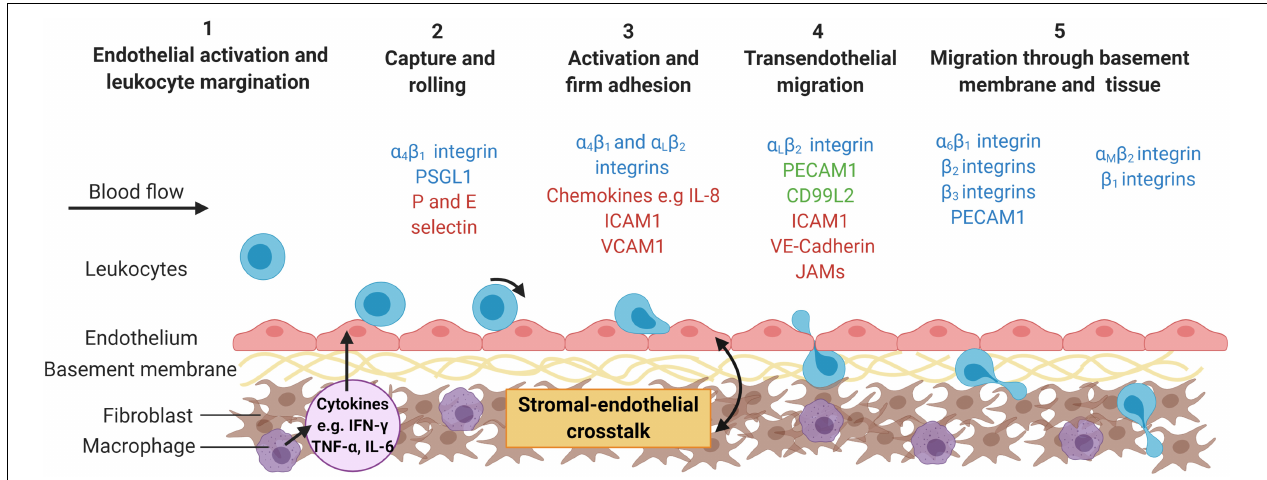
FIGURE 1 | The multi-step leukocyte adhesion cascade. Infection or tissue damage causes the localized release of danger signals, including cytokines, which (1) activate the endothelium causing the expression of capture receptors (P- or E-selectins), adhesion molecules (IgSF members – ICAM-1; VCAM-1) and presentation of chemokines or lipids on their surface (2) (Zhang et al., 2011). Marginated leukocytes are captured, roll along the endothelial surface until (3) they receive an activation signal (typically chemokine mediated) resulting in inside-out signaling and integrin activation ( α L β 2 -integrin; α 4 β 1 -integrin) (Ley et al., 2007). This allows for stabilization of the adhesive interactions ( α L β 2 -ICAM-1 and α 4 β 1 -VCAM-1 interactions) and cytoskeletal rearrangement in the leukocyte allowing (4) them to crawl over the endothelium, migrate across the endothelium (ICAM-1; JAM-1; CD31; VE-cadherin) and into the subendothelial space (Ley et al., 2007), (5) where they encounter the basement membrane and stromal compartment. This process is tightly regulated by the haemodynamic forces of the flowing blood and the stromal derived signals experienced by the endothelium (McGettrick et al., 2012). Some of the major molecules involved in this process are represented in the schematic, with molecules colored according to cell type expressing them; leukocytes = blue; endothelial cells (ECs) = red and expressed by both leukocytes and ECs = green. ICAM-1, Intracellular adhesion protein 1; IL-8, interleukin-8; JAM, junctional adhesion molecule; PECAM-1, platelet endothelial cell adhesion molecule 1; PSGL1, P-selectin glycoprotein ligand-1; VE-cadherin, vascular endothelial cadherin; VCAM-1, vascular adhesion protein 1. Created with